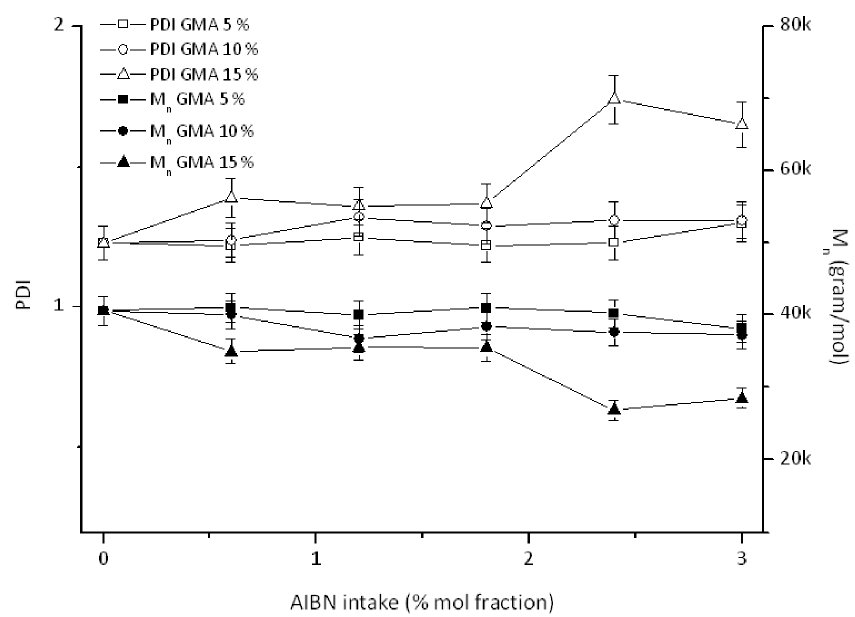
Figure 7. M n and PDI as function of AIBN intake.